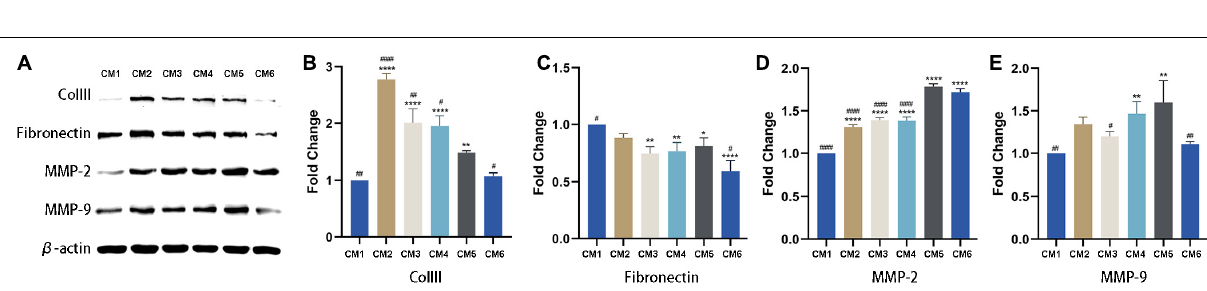
Frontiers in Cell and Developmental Biology |